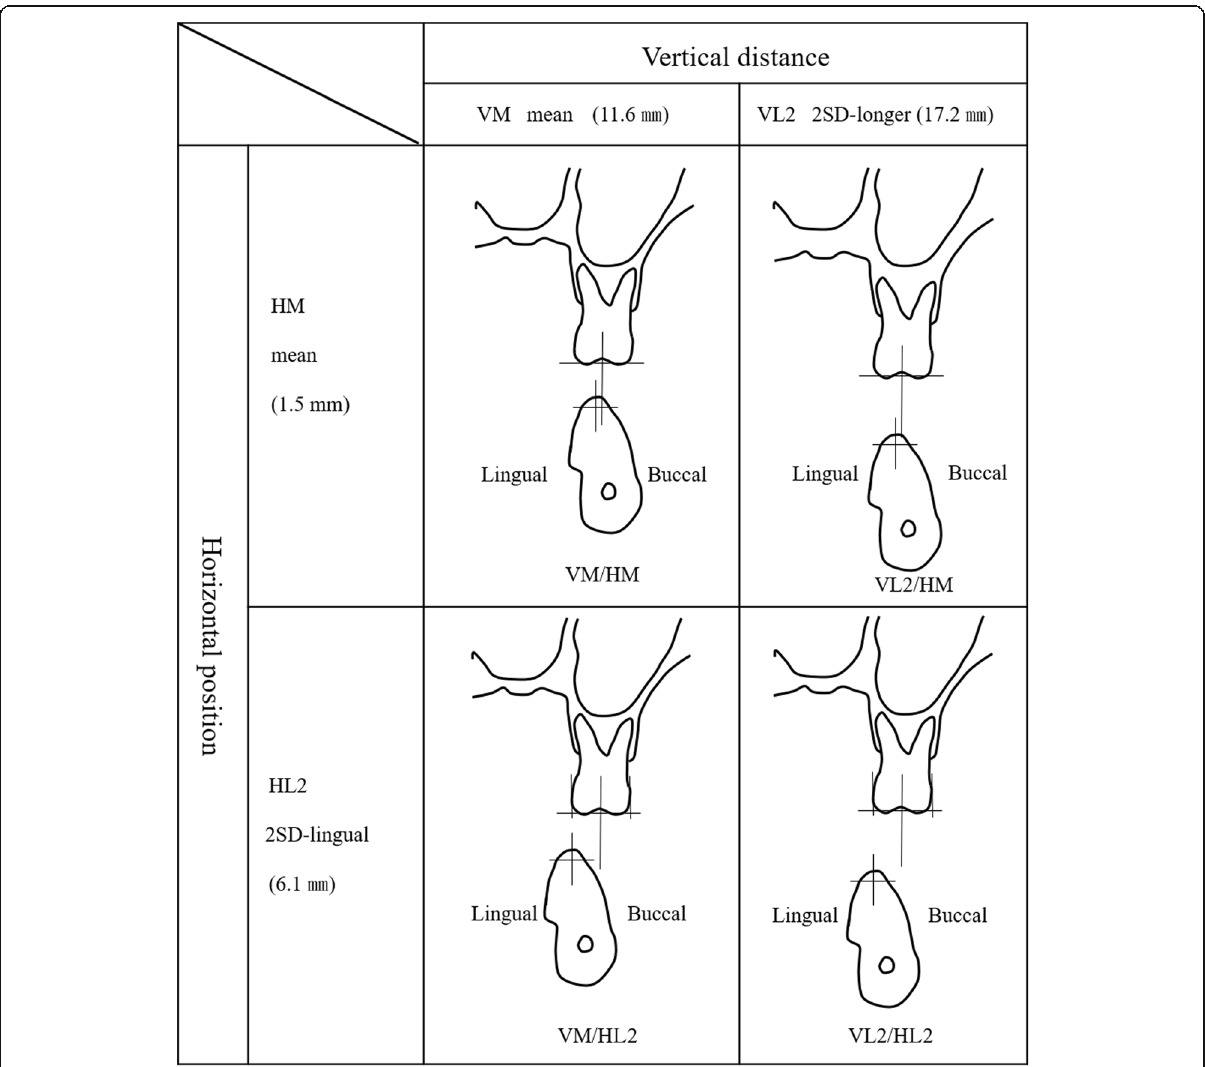
Fig. 6 The horizontal and vertical position between the maxillary first molar and the mandibular residual